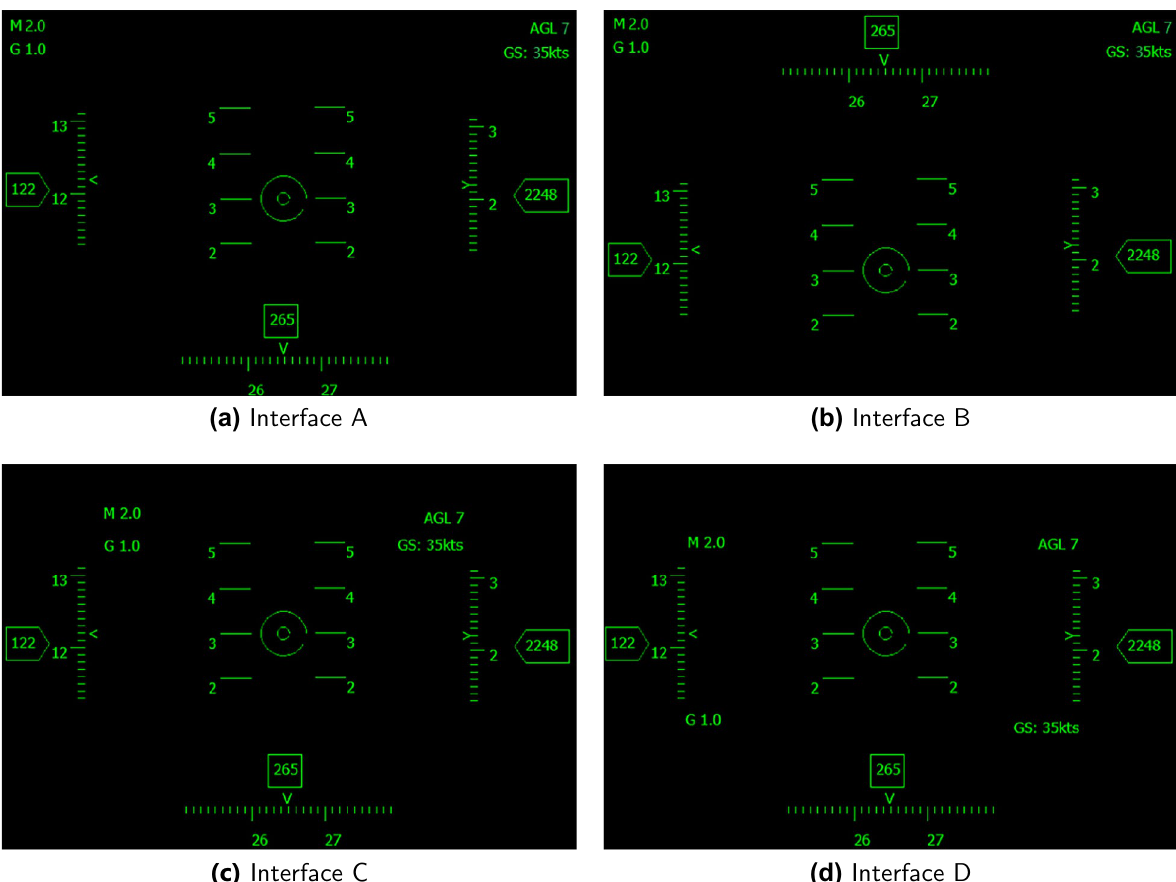
Fig. 1 Combining the classical aircraft HMD interface with flight simulation software FlightGear, determined the flight parameters and shape of our HMD interface element and designed four different HMD interfaces. The only difference between interface A , B lies in the location of azimuth icon. The only difference between interface C , D is the location of icon “M 2.0”, “AGL 7”, “G 1.0”, “GS: